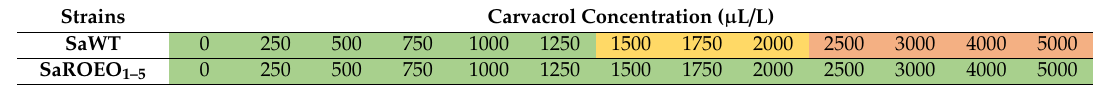
Table 1. Minimum inhibitory concentration (MIC; μ L/L) and minimum bactericidal concentration (MBC; μ L/L) of orange essential oil (OEO) for Staphylococcus aureus USA300 (SaWT) and evolved strain (SaROEO 1–5 , 5 isolated strains). Each value represents the result of 5 different experiments carried out for every strain tested, with different bacterial cultures and on different working days. Strains Carvacrol Concentration ( µ L / L)